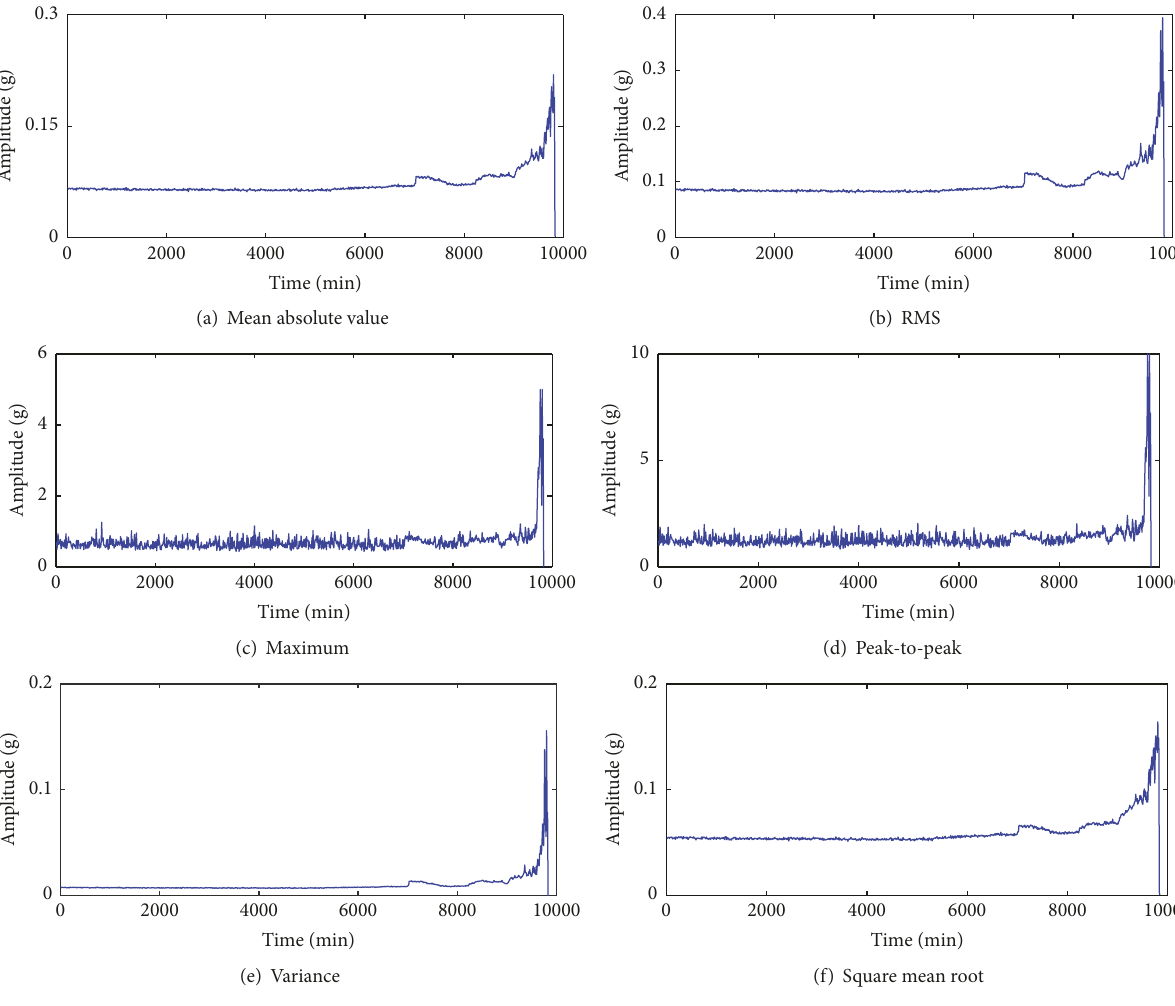
Figure 4: Six dimensional time domain